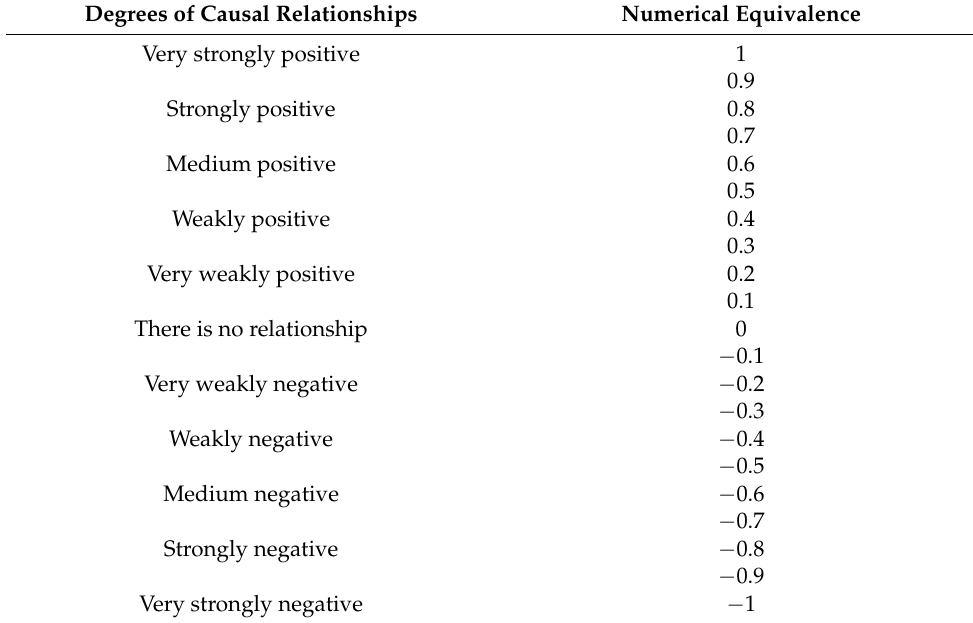
Table 2. Numerical assessment of cause–effect